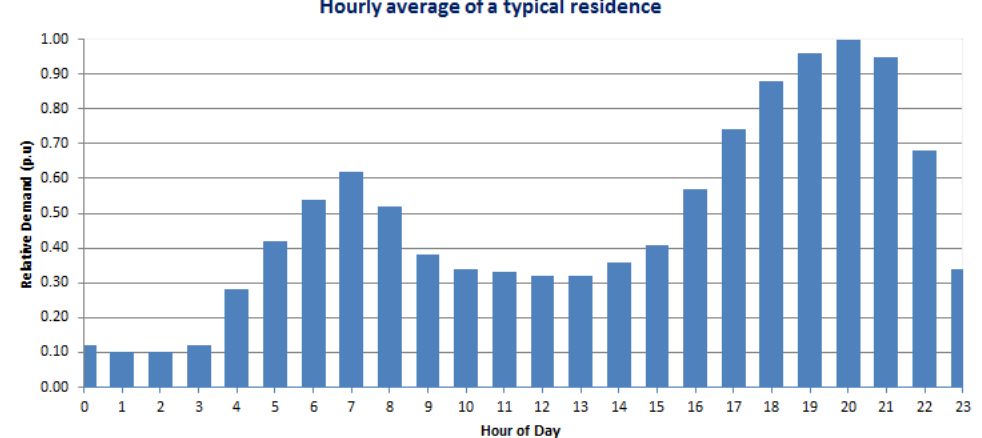
Figure 5. Hourly average relative demand for domestic load. Source [60].